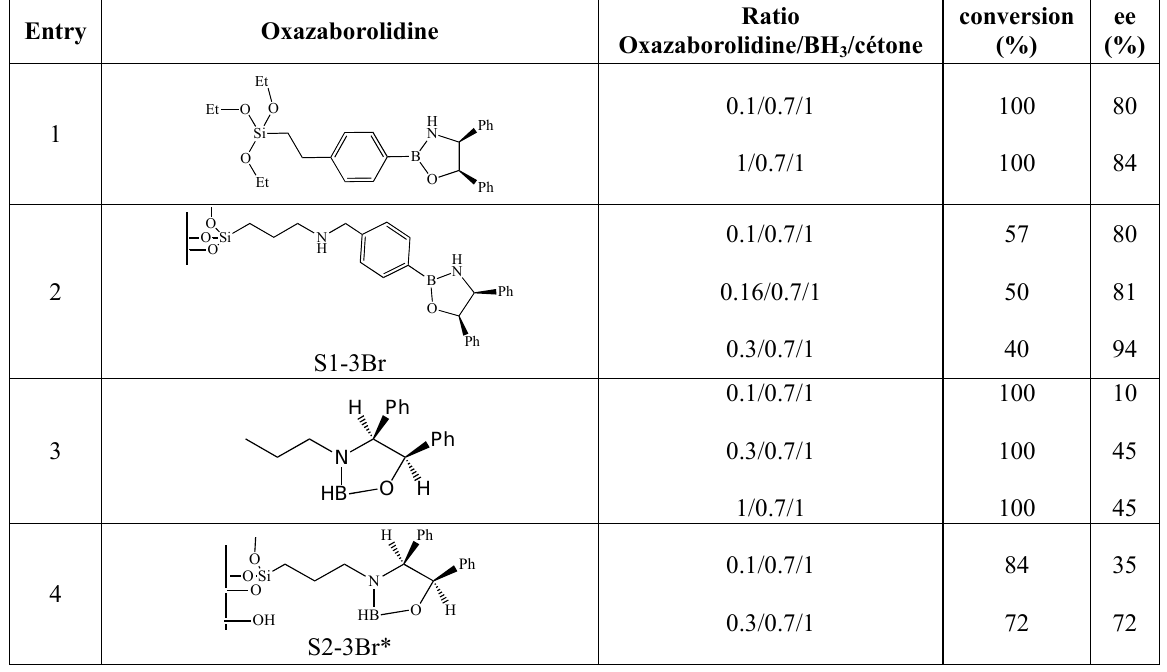
Table 5. Enantioselectivity comparison between homogeneous and supported oxazaborolidine. Entry